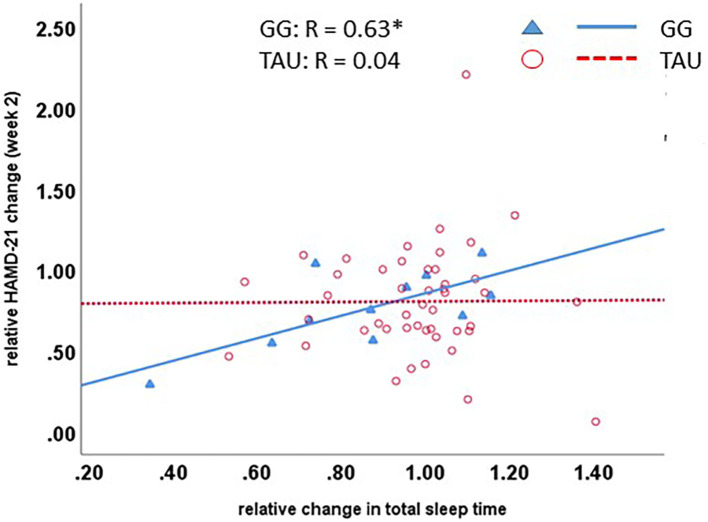
GG-induced biomarker changes are correlated with clinical change. A clinically better outcome, as determined by the HAMD-21 ratio, is significantly correlated with a reduced total sleep time in the GG group. GG, Glycyrrhiza glabra add-on; TAU, treatment as usual.